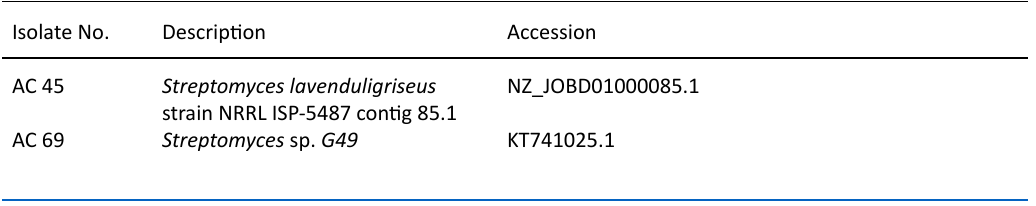
Table 2. List of BLAST results for the 16S sequence Isolate